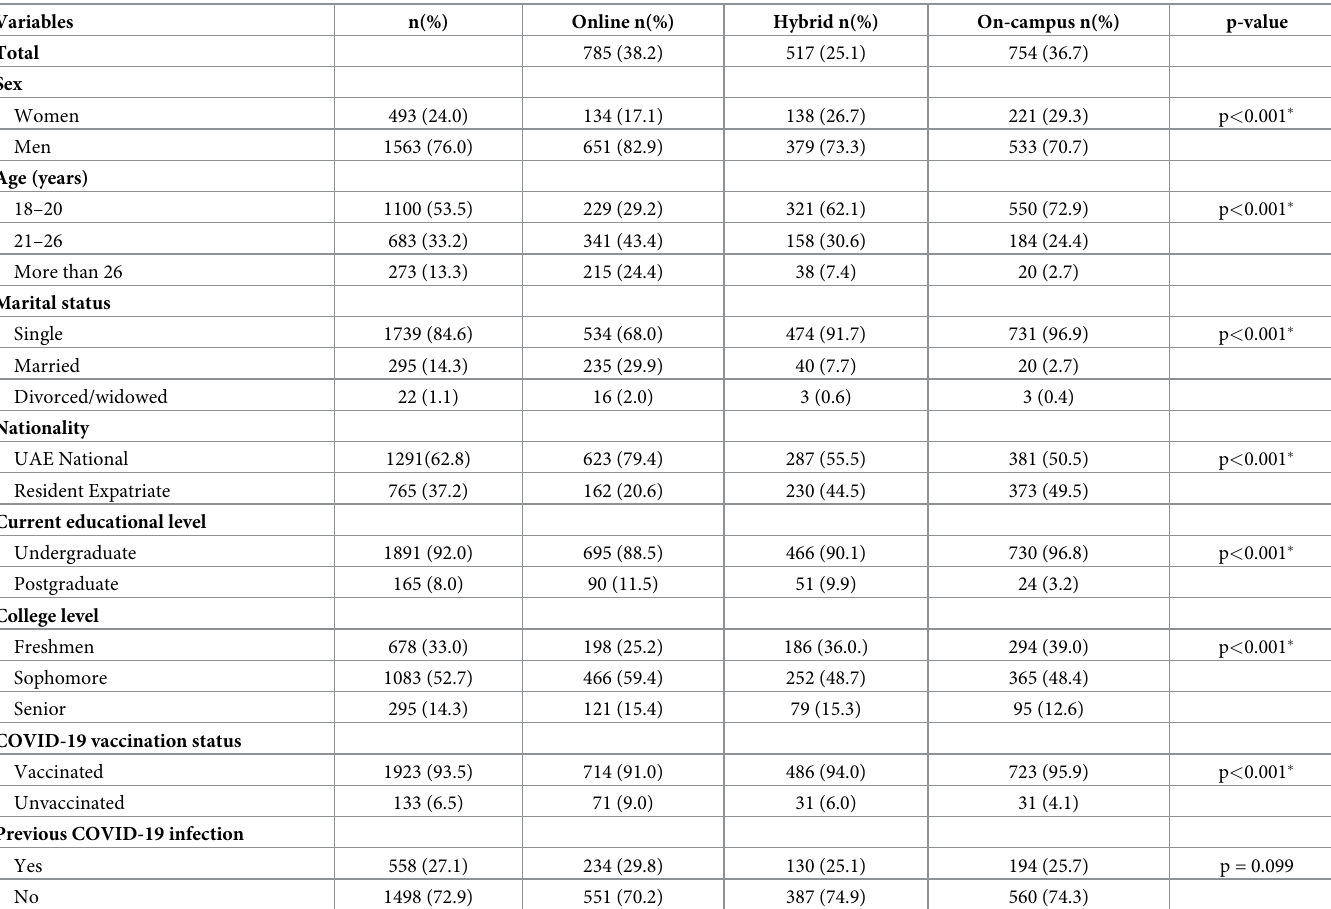
Table 1. Demographic characteristics of participants and preferred mode of learning by demographic factors (n =